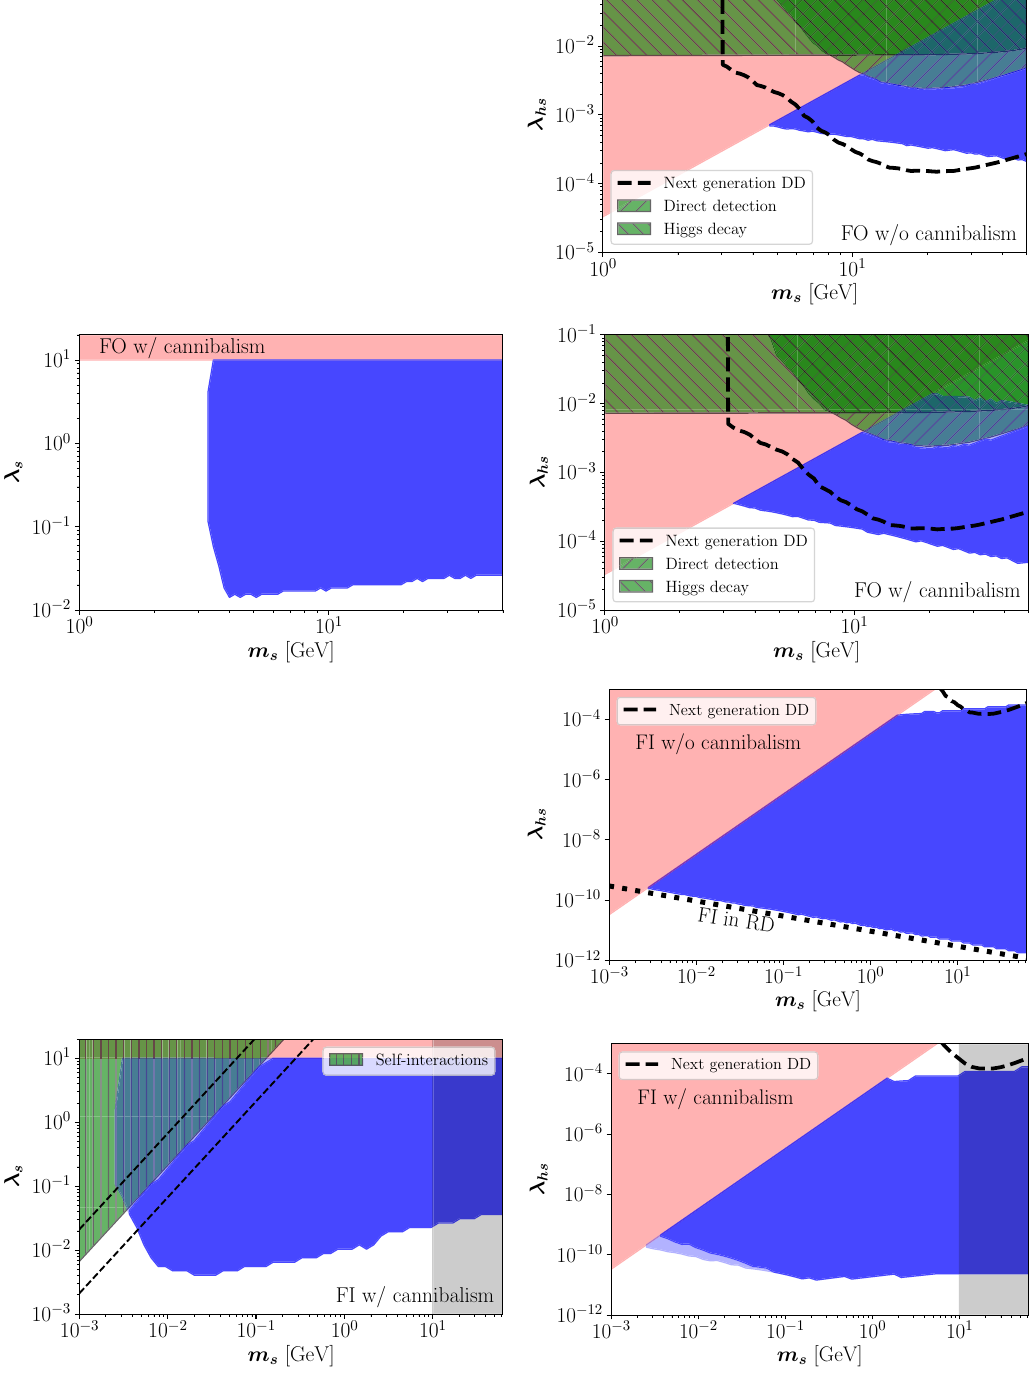
Fig. 8 Detection prospects for frozen-out and frozen-in DM with and without cannibalism, as indicated in the figures. The green regions are excluded by different measurements: DM direct detection, invisible Higgs decay, or DM self-interactions. The blue regions give rise to the observed DM relic abundance, the light blue being already in ten- sion with observations. The black thick dashed line corresponds to the bounds that might be reached by next generation direct detection DM experiments. The red regions correspond to the constraints discussed in Sect. 2.2: the SM temperature after the matter-like component has